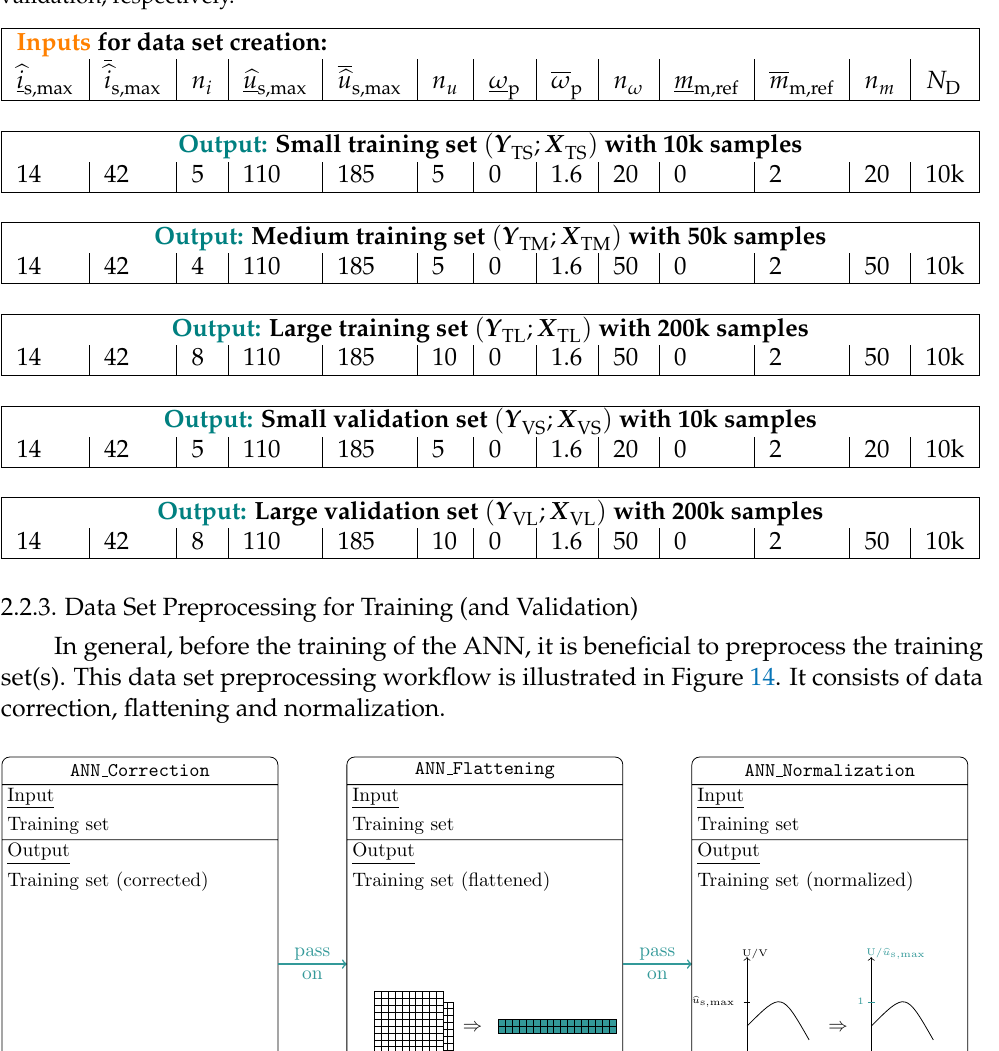
Table 4. Inputs for data set creation by the software framework illustrated in Figure 11: The created data set(s) are then split into three training and two validation data sets used for ANN training and validation, respectively.